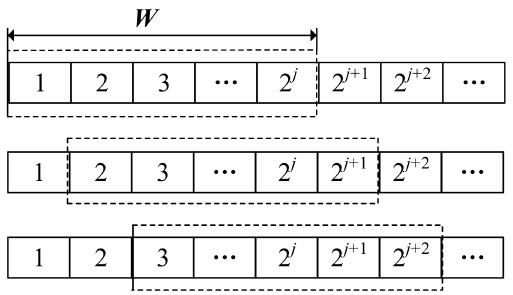
Figure 5. Schematic diagram of the sliding window movement.